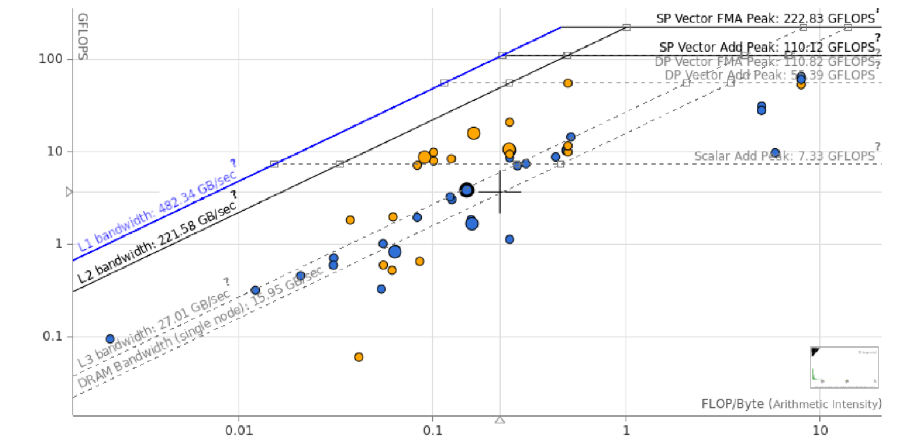
Figure 1. Example of a roofline analysis plot obtained with Intel Advisor; the y axis corresponds to the number of floating points per second (in GFLOPS units) and the x axis is the arithmetic intensity (i.e. how many operations are made per byte loaded in the memory registers, in FLOP / Byte units); each dot corresponds to a di ff erent function or loop in the code, the size of the dot indicates the exclusive time spent in that function or loop, while the color indicates whether the loop is scalar (blue) or vectorized (orange).